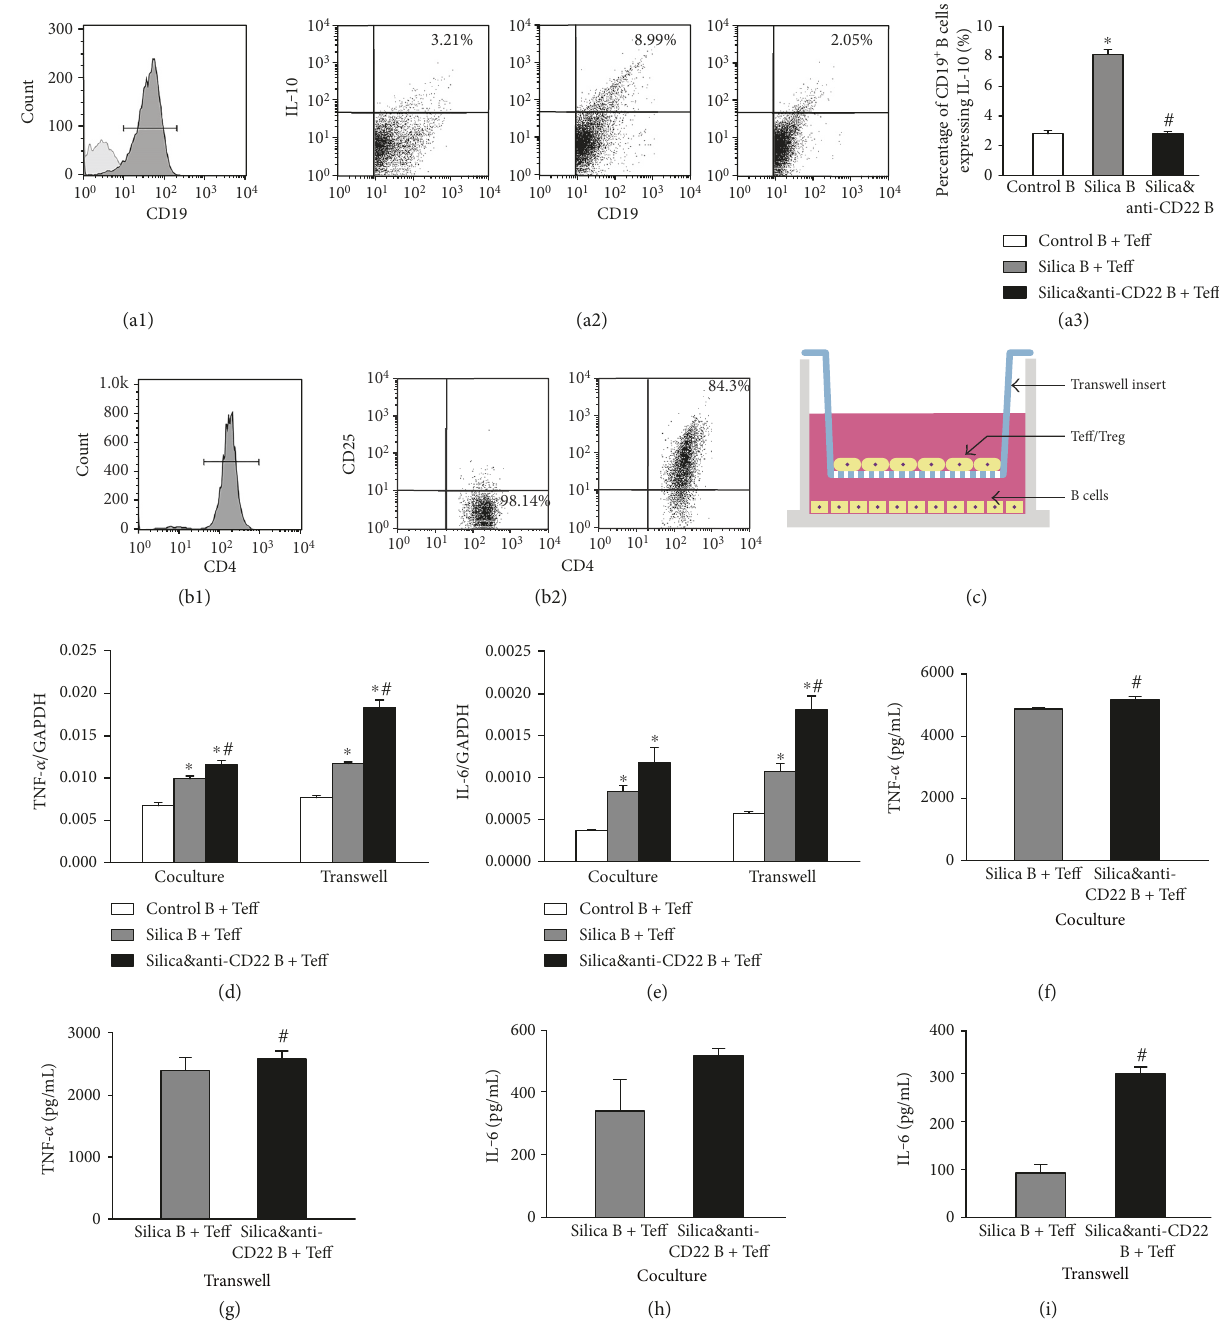
Figure 1: Insu ffi cient B10 promoted the proin fl ammatory cytokines in the Te ff and B cell coculture system in vitro. (a1) CD19 + B cells were puri fi ed and checked by fl ow cytometry. (a2, a3) The percentages of B10 in di ff erent groups were tested by fl ow cytometry. (b1, b2) The CD4 + CD25 − Te ff and CD4 + CD25 + Treg were puri fi ed and checked by fl ow cytometry. (c) A schematic of B cell and Te ff coculture system with insert plates in vitro. (d, e) The expressions of TNF- α and IL-6 in di ff erent groups of the B cell and Te ff coculture system with or without insert plates were assayed by real-time PCR. (f, h) The secretions of TNF- α and IL-6 in supernatant of the B cell and Te ff coculture system were assayed by CBA. (g, i) The concentrations of TNF- α and IL-6 in supernatant of the B cell and Te ff coculture system with insert plates were assayed by CBA. (Data was presented as mean ± SEM ( n = 5 ). ∗ p < 0 05 , signi fi cantly di ff erent compared with the control B+Te ff group. # p < 0 05 , signi fi cantly di ff erent compared with the silica B+ Te ff